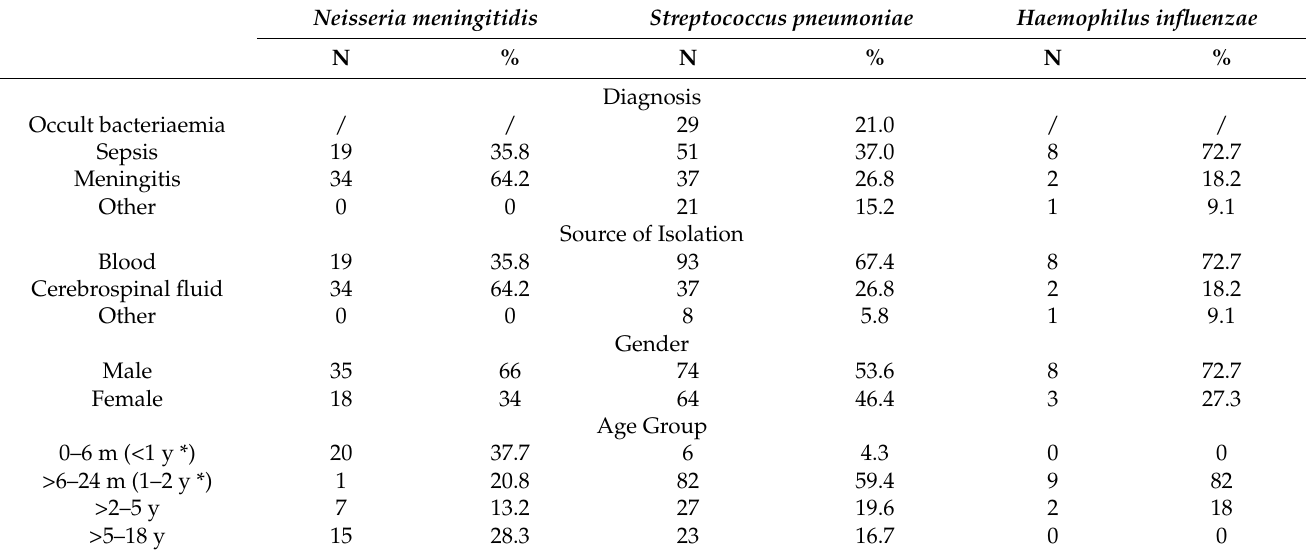
Table 1. Clinical diagnosis, gender, age, and source of isolation of invasive isolates. Neisseria meningitidis Streptococcus pneumoniae Haemophilus